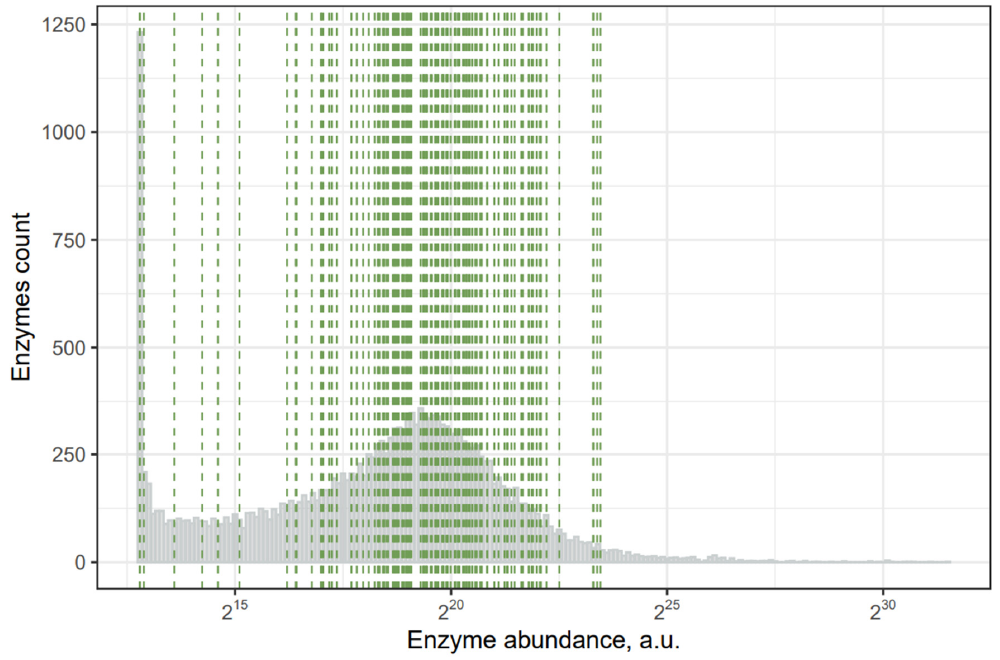
Figure 1. Abundance of human mRNA expression in the whole organism: green lines—genes of uremic-retention-solutes-synthesizing enzymes.